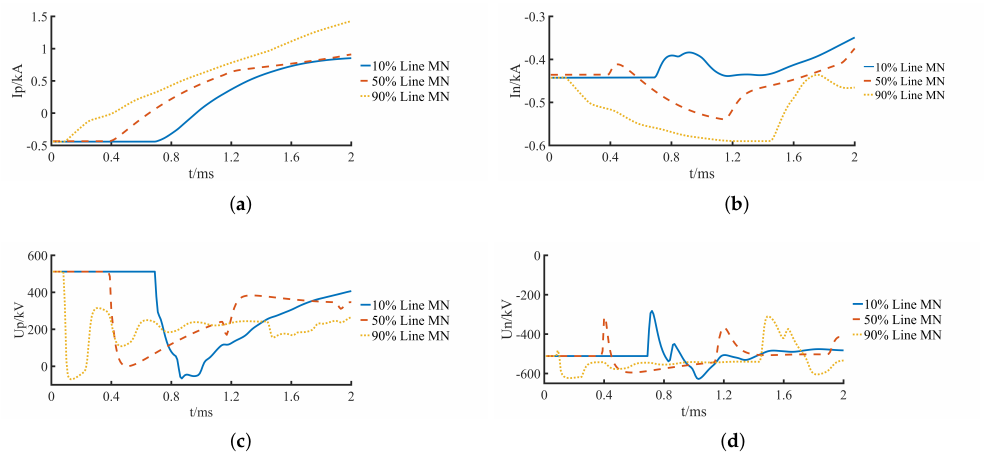
Figure 5. The PG fault waveforms at different locations of the Line MN. ( a ) The fault waveforms of Ip; ( b ) The fault waveforms of In; ( c ) The fault waveforms of Up; ( d ) The fault waveforms of